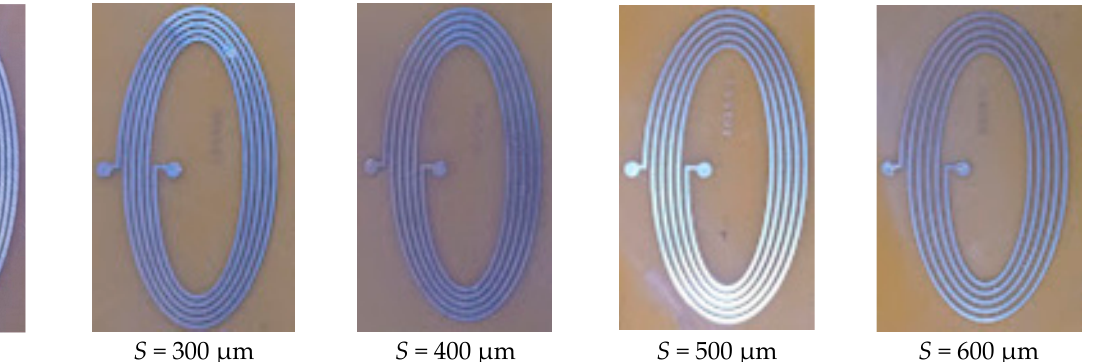
Figure 9. Elliptical planar inductors with trace width ( W ) of 600 μ m and varying trace separation ( S ) while major-to-minor ratio ( R ) = 3 and number of turns ( N ) = 5. Table 5. Inductance of elliptical inductors calculated from the proposed model for different combi- nations of trace separation ( S ) and trace width ( W ) while major-to-minor ratio ( R ) = 3 and number of turns ( N ) = 5.